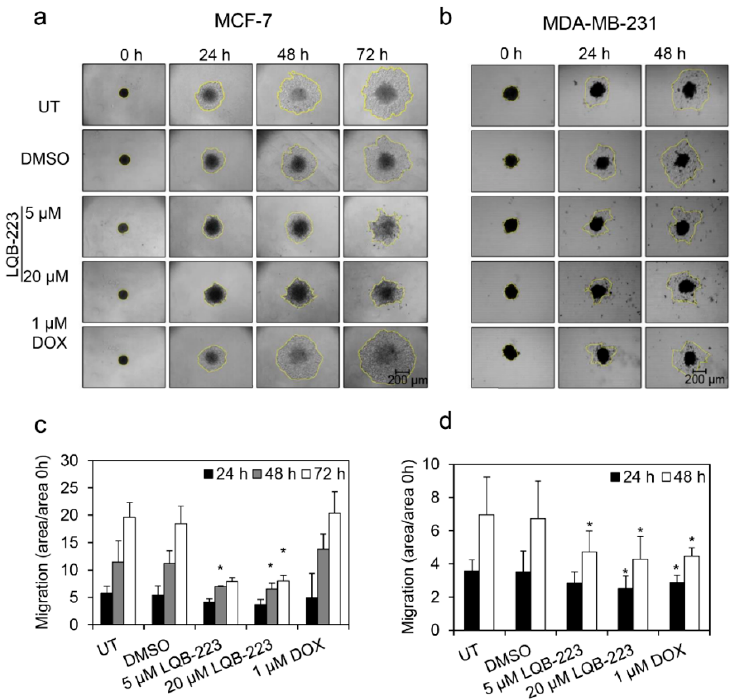
Figure 4. Analysis of cell migration cultivated as 3D cultures after treatment with LQB ‐ 223. ( a ) Fully ‐ formed spheroids of MCF ‐ 7 or ( b ) aggregates of MDA ‐ MB ‐ 231 were plated onto 24 ‐ well plates coated with gelatin, and migration was assessed over time upon exposure to LQB ‐ 223 or DOX. Area of cells migrated outwards from the 3D structure was calculated for ( c ) MCF ‐ 7 and ( d ) MDA ‐ MB ‐ 231; aggregates were calculated and divided by the area of the 3D cultures on day 0. Values reported as mean and standard deviation of three independent experiments. Statistical significance was analyzed using the Student’s t test (* p < 0.05). UT: Untreated cells; DMSO: Dimethyl sulfoxide; DOX: Doxorubicin.